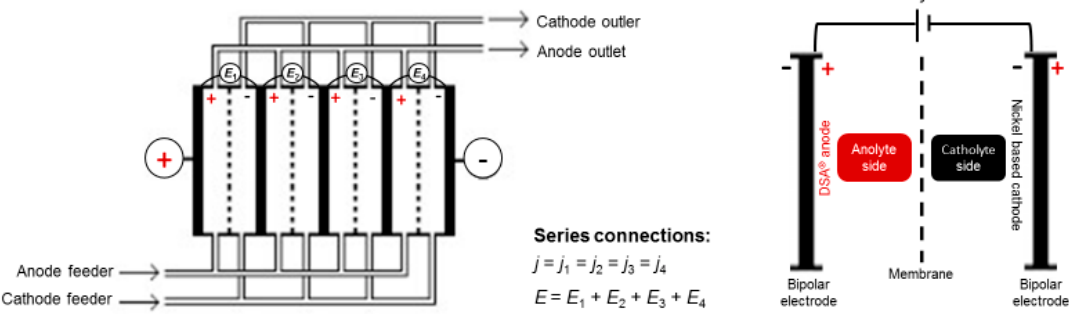
Figure 1. Scheme of a bipolar electrolyser where the stack consists of four cells connected in series: the potential between the terminals, E , is the sum of the individual potential of the cells and the same current density, j , flows through the cells.